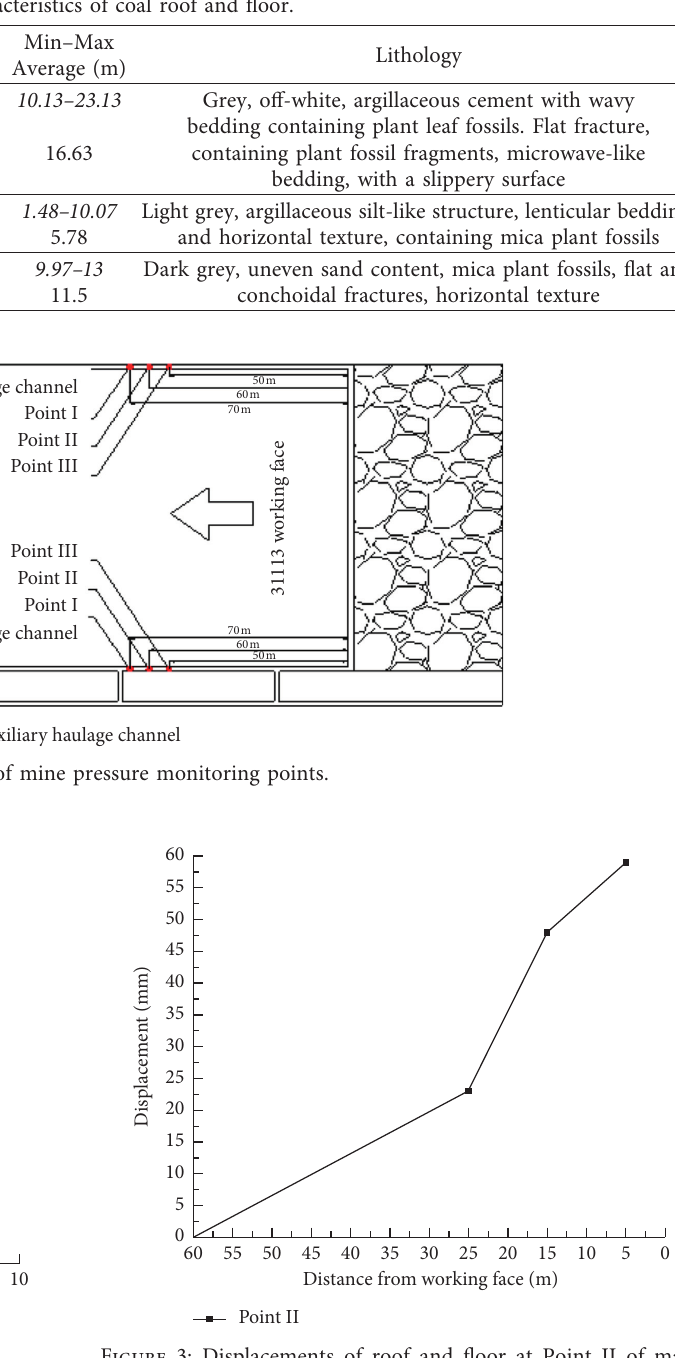
Figure 2: Displacements of roof and floor at Point I of main haulage channel.